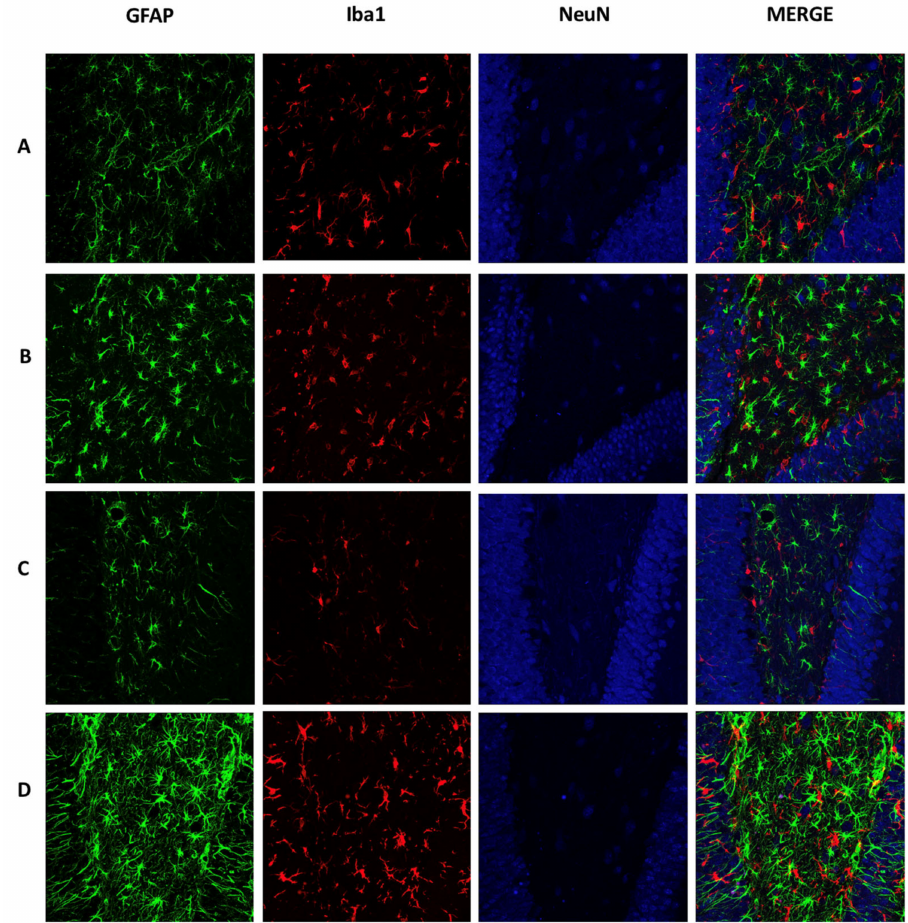
Figure 3. Acute cellular response mediated by A β O. Brain sections were immunolabeled to detect mature neurons (Anti-Neun, Cy5), astrocytes (Anti-GFAP, Alexa 488), and microglia cells (Anti-Iba, Alexa 555). Representative images (40 × ) of DG show the cellular response in the groups: ( A ) SS 18 h, ( B ) A β 18 h, ( C ) SS 72 h, and ( D ) A β 72 h. A β O treatments ( B and D ) increase astrocytes and microglial cells, as well as neuronal density in